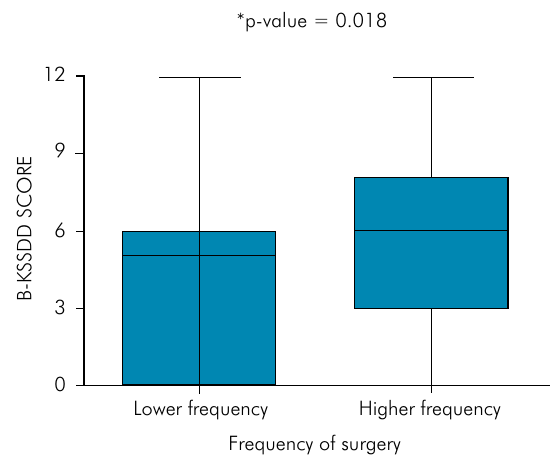
Figure 1. Analysis of the discriminant validity of the Brazilian Knowledge Scale about Sports Doping in Dentistry